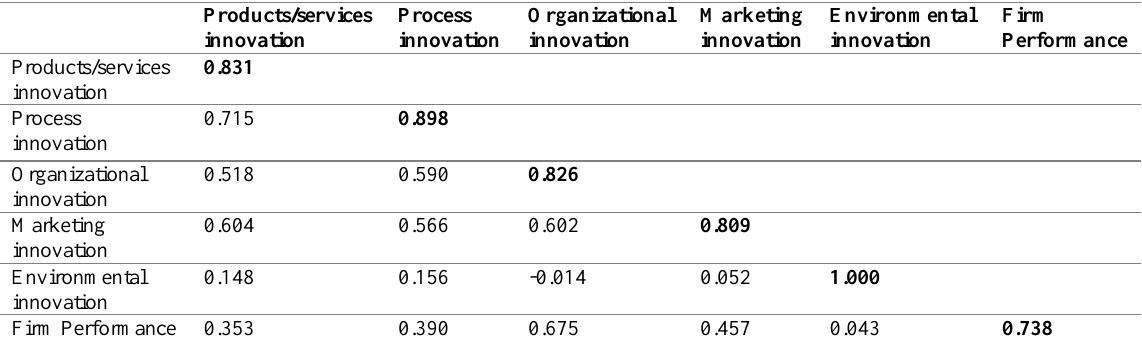
Table 7: Result of the Fornell-Larcker criterion (Discriminant Validity)